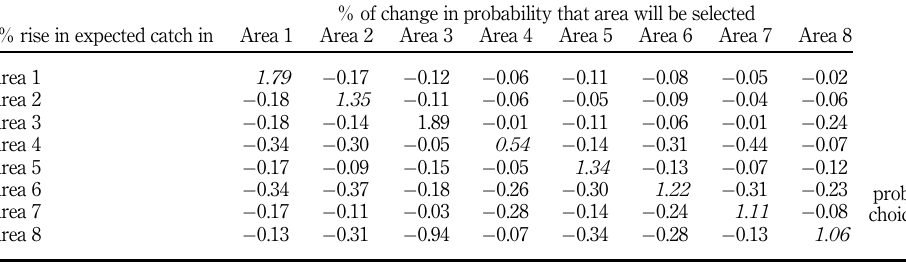
Table 6. Elasticities of